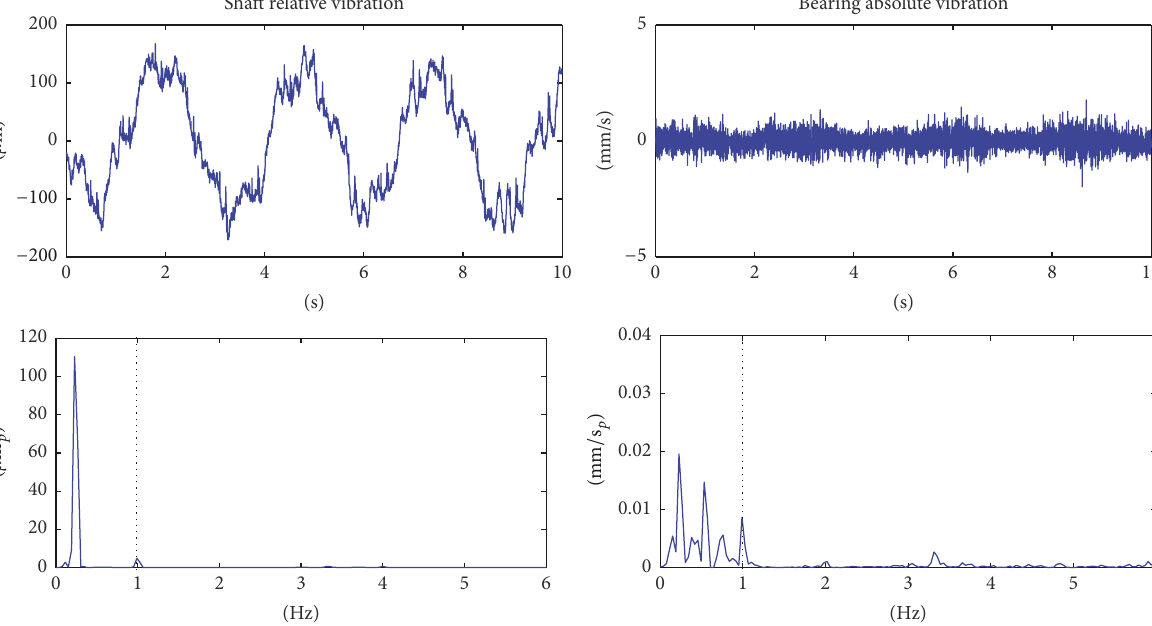
Figure 11: Shaft relative and bearing absolute vibrations at X -direction of the lower journal bearing, with a balanced generator rotor operating with 320